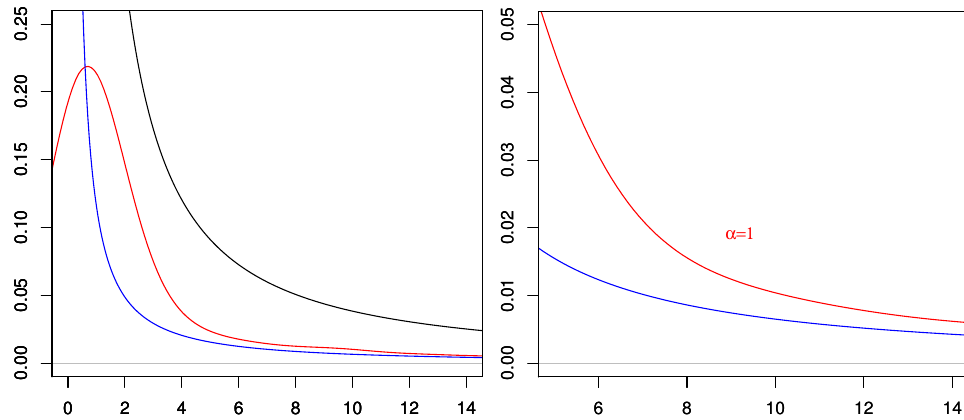
Figure 2. Case α = 1. Simulation details as in Figure 1. On the left : the red curve is simulated. The black curve is the plot of S 1/6 · t − ( 3 + 2 α ) / ( 2 α + 2 ) = S 1/6 t − 5/4 with S = 0.1. The blue curve is then obtained as the product of the black curve and the constant c α , whose estimated value is c α = 0.177. On the right is a zoom of the simulated density (red) and the approximation curve (blue) corresponding to those on the left.